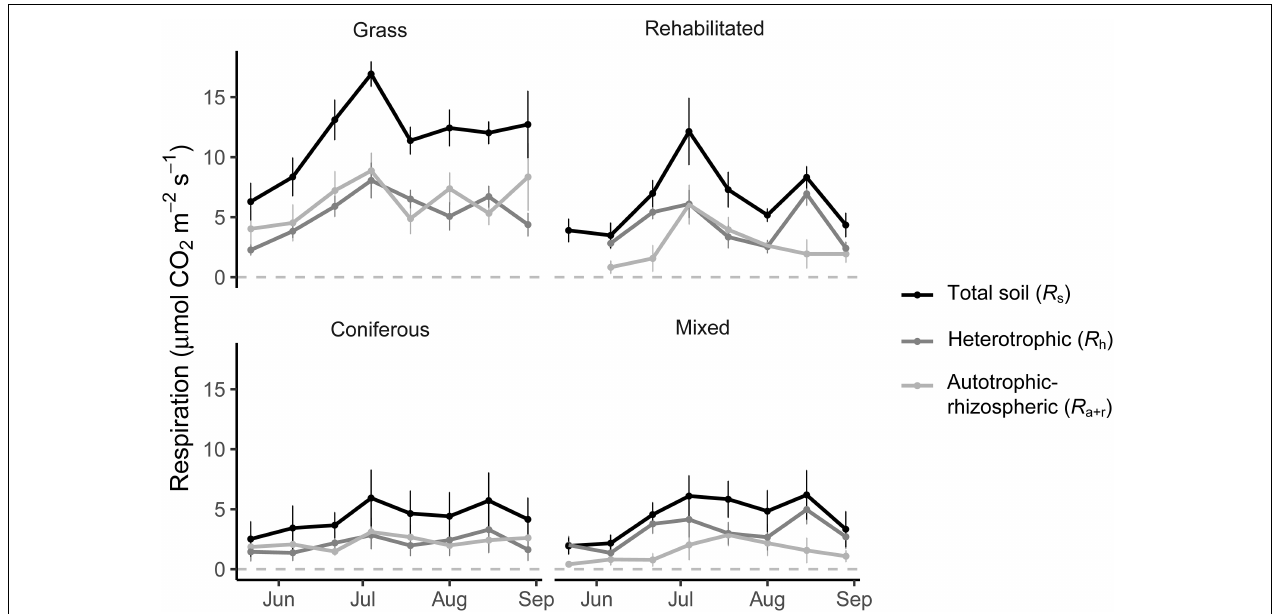
FIGURE 1 | Soil respiration rates ( µ mol CO 2 m - 2 s - 1 ) measured from root inclusion and exclusion sub-plots. Data shown are means ± SE of sampling plots ( n = 4) from each land